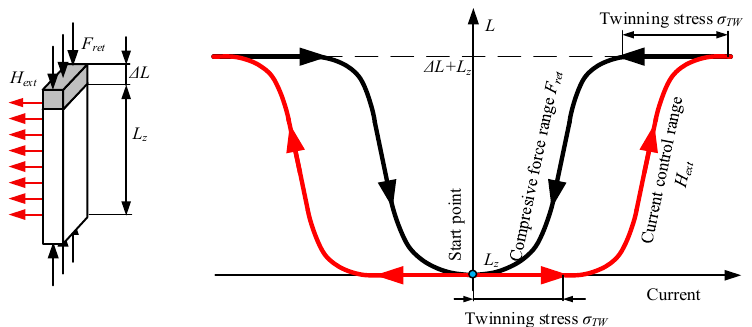
Figure 2. Spring operating mode—theoretical curve strain vs. current, where L z is the length of the MSMA element, ∆ L is MSMA deformation, H ext is the strength of the external magnetic field, F ret is the compressive force, and σ TW is the twinning stress.